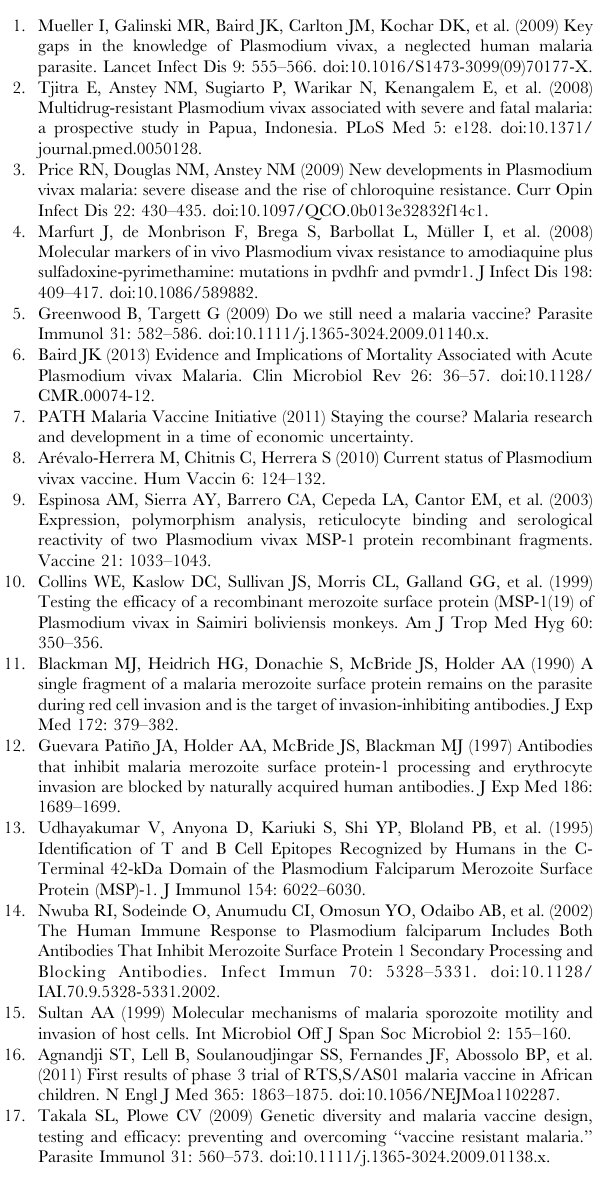
Figure S1 Geographic distribution of P. vivax popula- tions contributing to this study. In total, we identified 13 populations with pvmsp-1 42 kDa fragment sequences and 13 populations with pvcsp central repeat or whole-gene sequences. These populations were collected from 14 countries, pictured above. For countries with n $ 10 isolates, the total number of pvmsp-1 and pvcsp isolates is marked. Figure S2 F ST values at polymorphic sites within the pvmsp-1 42 kDa intervening region. Available parasite populations with n . 25 individuals (Cambodia, India, NW Thailand, S Thailand, and Turkey) share 42 variable sites within the 42 kDa intervening region of pvmsp-1 . F ST values for each variable site were calculated in a pairwise manner between all five populations. F ST values approaching 0 indicate limited